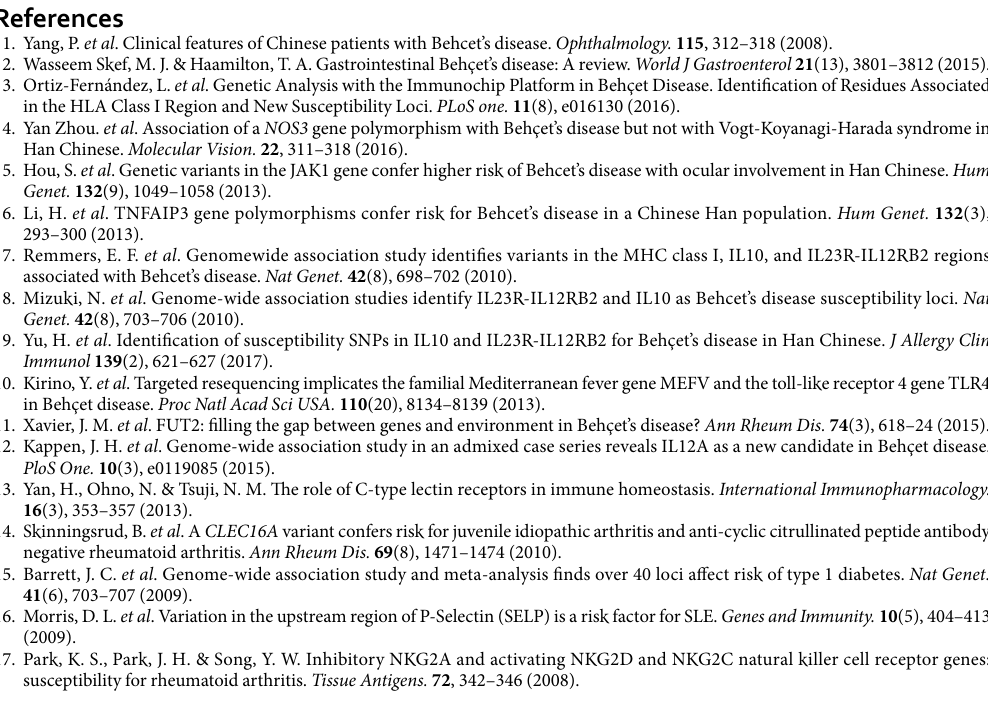
For multiple comparisons, the Bonferroni correction was used to adjust P values to corrected P values (Pc) according to the number of performed analyses. A p c < 0.05 was viewed as significant. Expression of KLRC4 , MBL2 and cytokine levels among three genotype groups was tested by the non-parametric Mann-Whitney test or student t test, with P < 0.05 (Two-tailed) taken as being statistically significant.